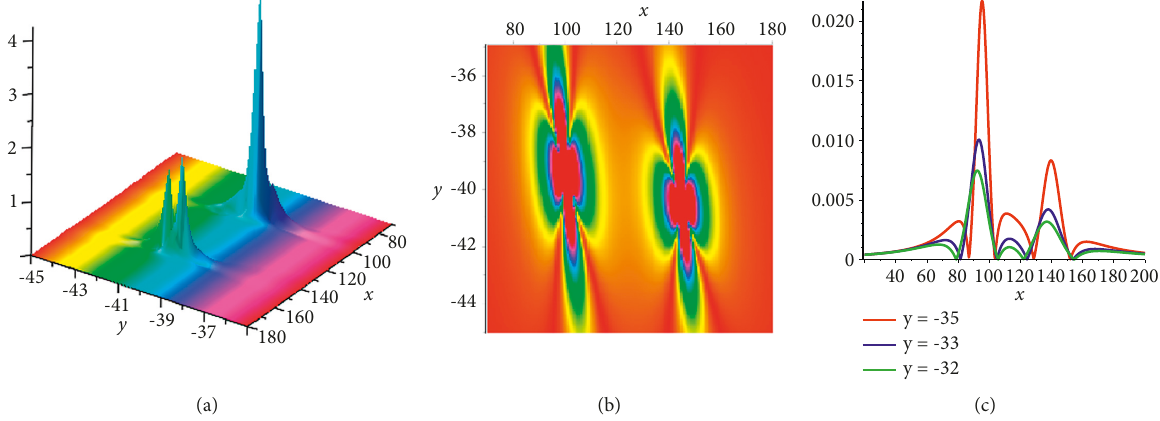
Figure 5: Plot of equation (48) by taking a � 1 , b � − 2 . 5 , c � 1 , d � 2 , c